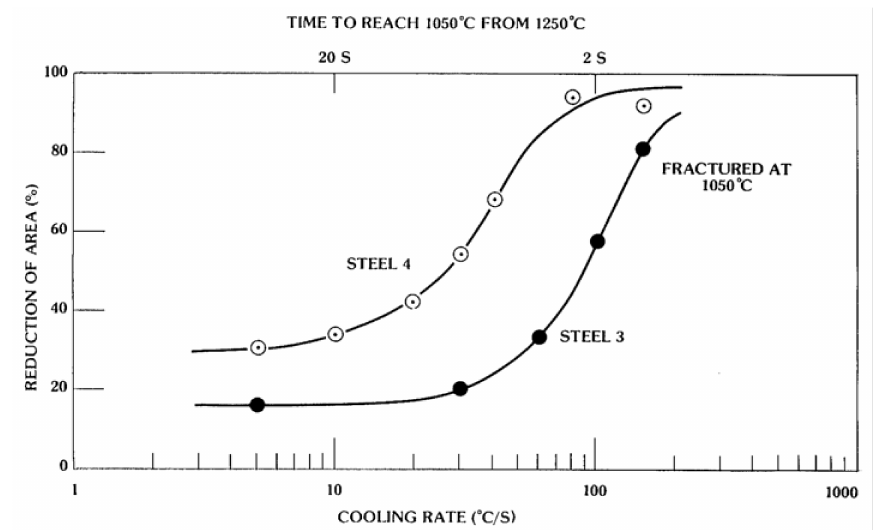
Figure 25. Effect of cooling rate on hot ductility of steels 3 and 4. Reprinted from ref. [37].